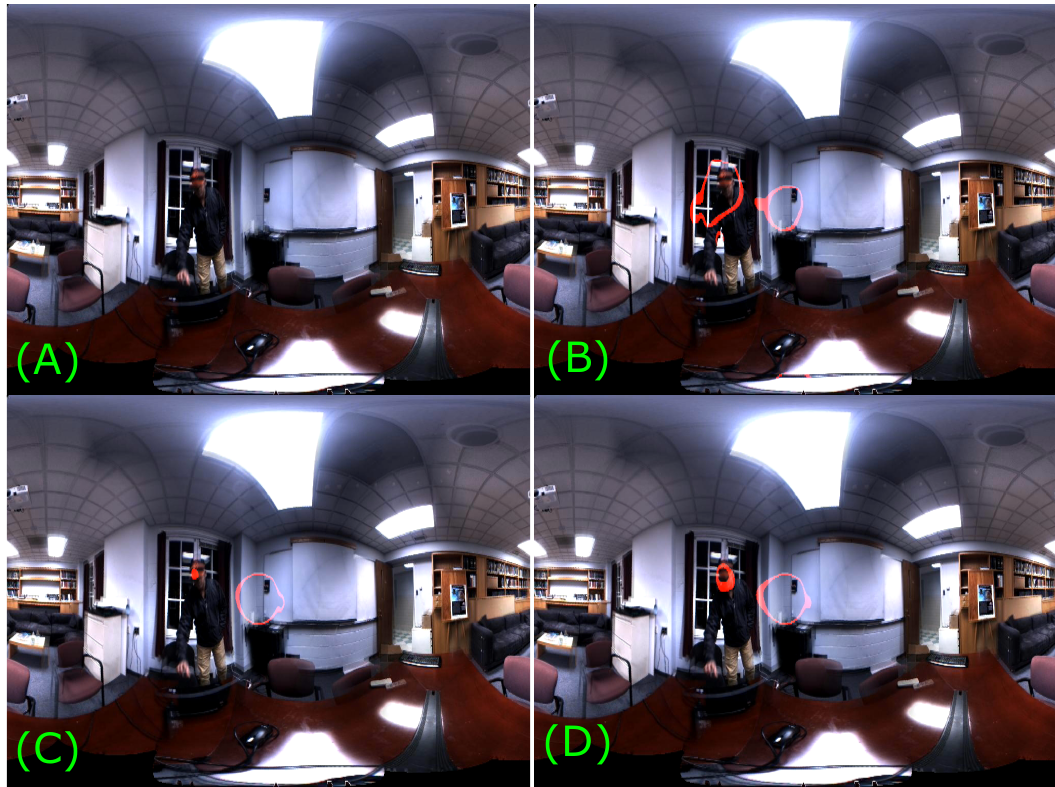
Figure 8. Comparison of audiovisual saliency computation methods. ( A ) Input Frame #393 of Dataset 1. A small loudspeaker at the corner of a room, which is located almost at the center of the image frame, is playing a documentary, hence constitutes a salient stationary auditory event. The person is leaning forward gives rise to salient visual motion. ( B ) AVSM 1 computed using Equation (8) where all five feature channels are combined linearly with equal weights. ( C ) AVSM 2 computed using Equation (9) where VSM and ASM are averaged. ( D ) AVSM 3 computed using Equation (10). All methods give similar results with minor